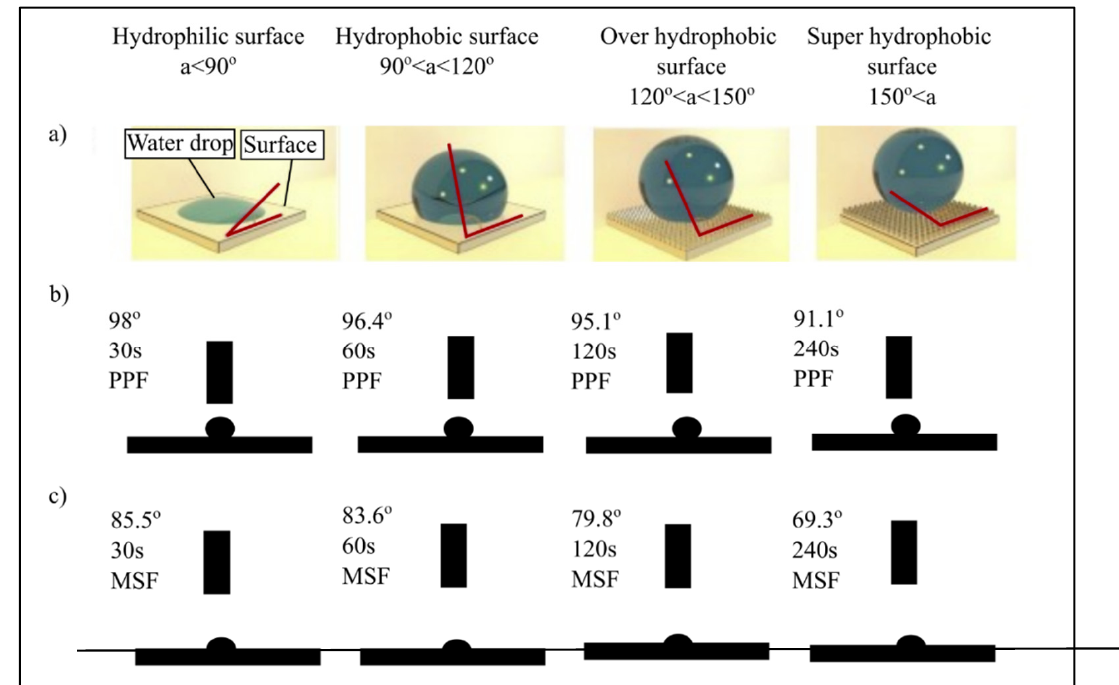
Figure 8. The general categorization of hydrophobicity ( a ) and water contact angle of PPF ( b ) and MSF ( c ) at 30, 60, 120, and 240 s [21].